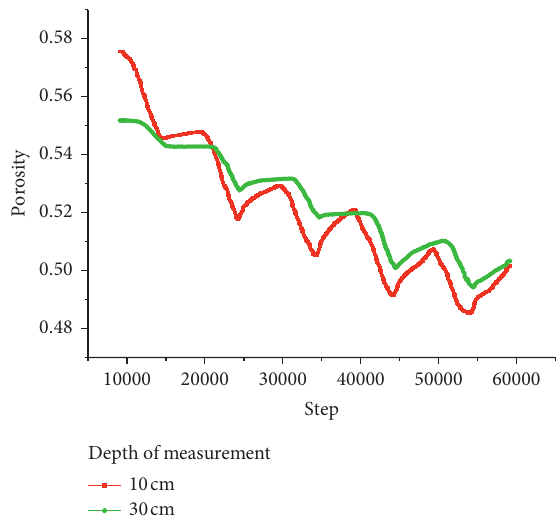
Figure 20: Curve of porosity change of 50cm thick reclaimed soil with five Table 7: Numerical simulation results for soil thickness of 50 cm.